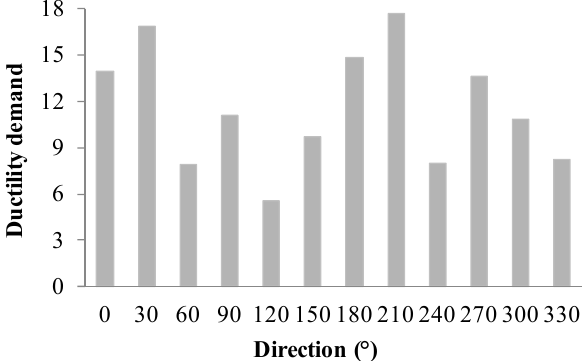
Figure 22. Assessment of the admissible ductility along all the investigated directions.